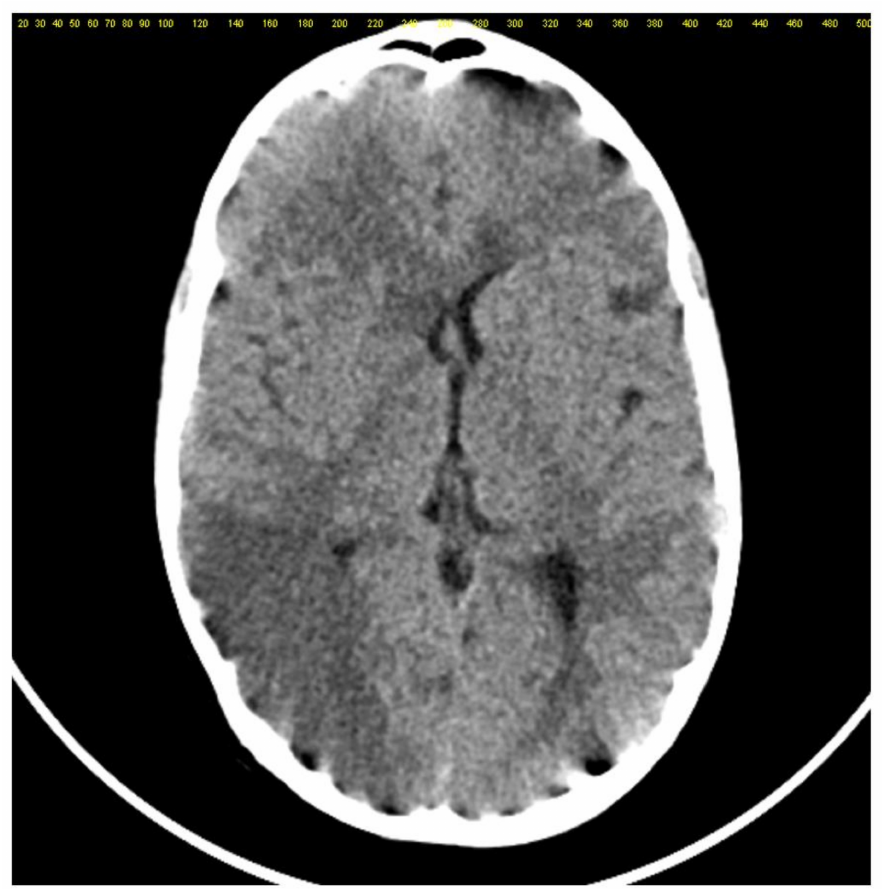
Figure 1. AngioCT modifications with multiple areas of hypodensity in the right parietal lobe and left pericallosal cerebral hypodensity associated with hyperdensity in the surrounding